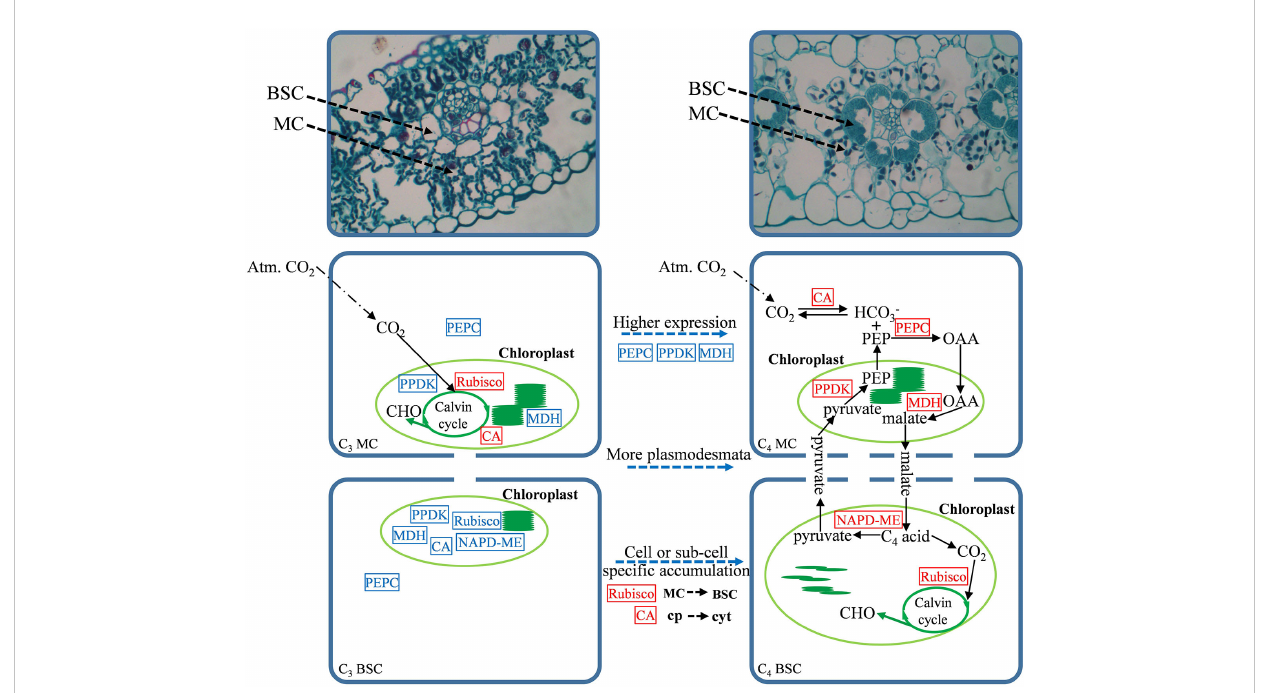
FIGURE 5 Schema of C 3 photosynthesis and NADP-malic enzyme (NADP-ME)-type C 4 photosynthesis in gramineous crops. From top to bottom are the anatomical structure and photosynthetic model. The dotted line in the middle marks the necessary steps for the photosynthetic pathway to evolve from C 3 to C 4 . Cp is the chloroplast, cyt is the cytoplasm, and the red box and blue box represent high/low expression levels,